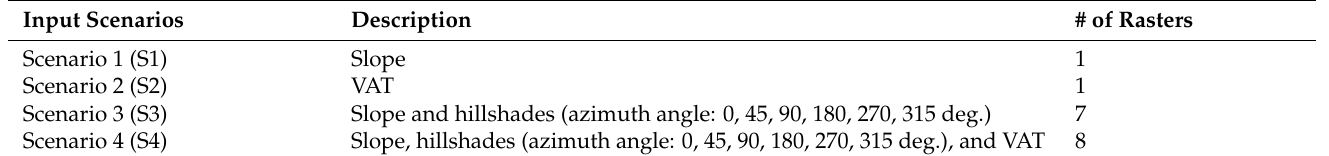
Table 2. Description of four input scenarios used in this